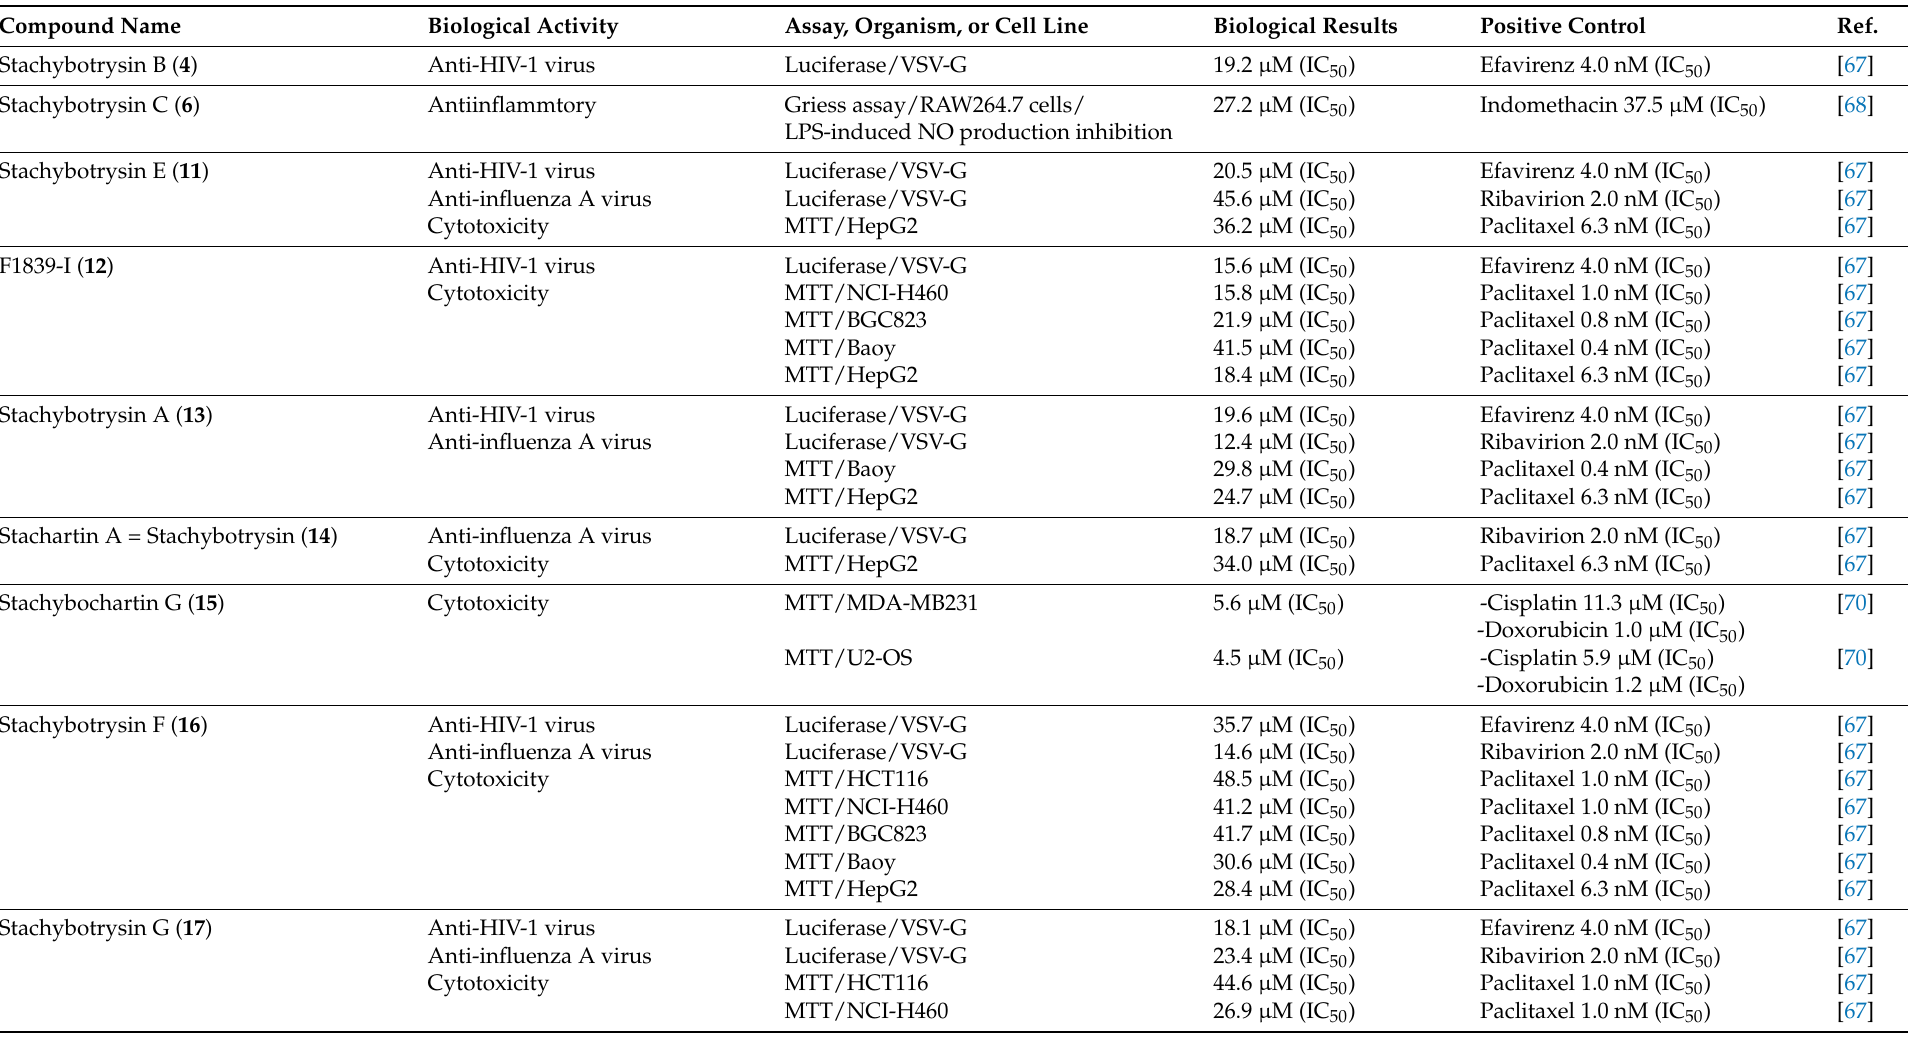
Table 2. List of biological activities of compounds isolated from Stachybotrys chartarum